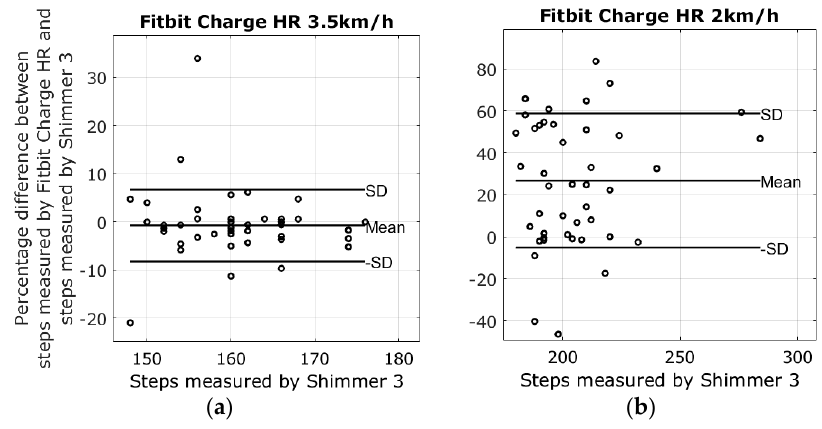
Figure 4. Results from the walking tests with plots showing the difference between the steps measured by the Fitbit Charge HR and the Shimmer 3. ( a ) The percentage error of the 3.5 km/h walking test is − 0.7 ± 7.5; ( b ) The percentage error of the 2 km/h walking test 26.8 ± 32.0.